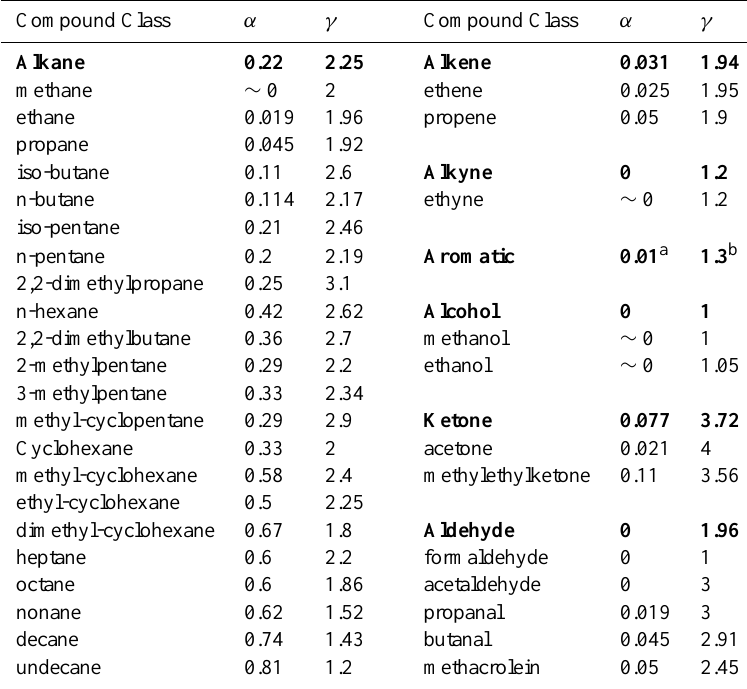
Table 2. Summary of specific organic nitrate yield ( α ) and ozone yield ( γ ) calculated at 0 ◦